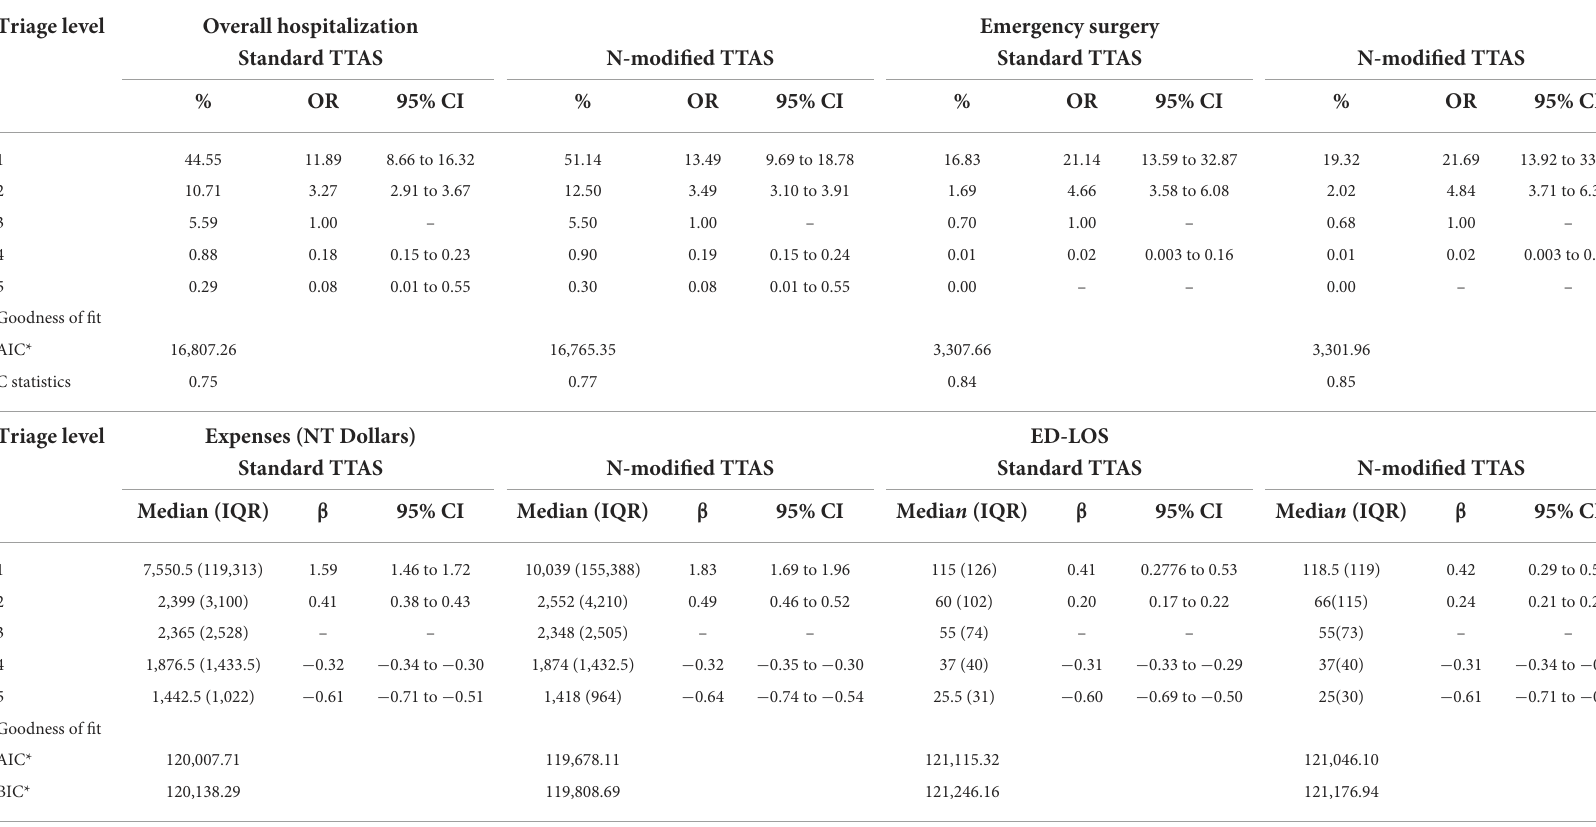
TABLE 2 Comparison of effectiveness in pediatric trauma patients between the standardized TTAS and nurse-modification TTAS ( n =